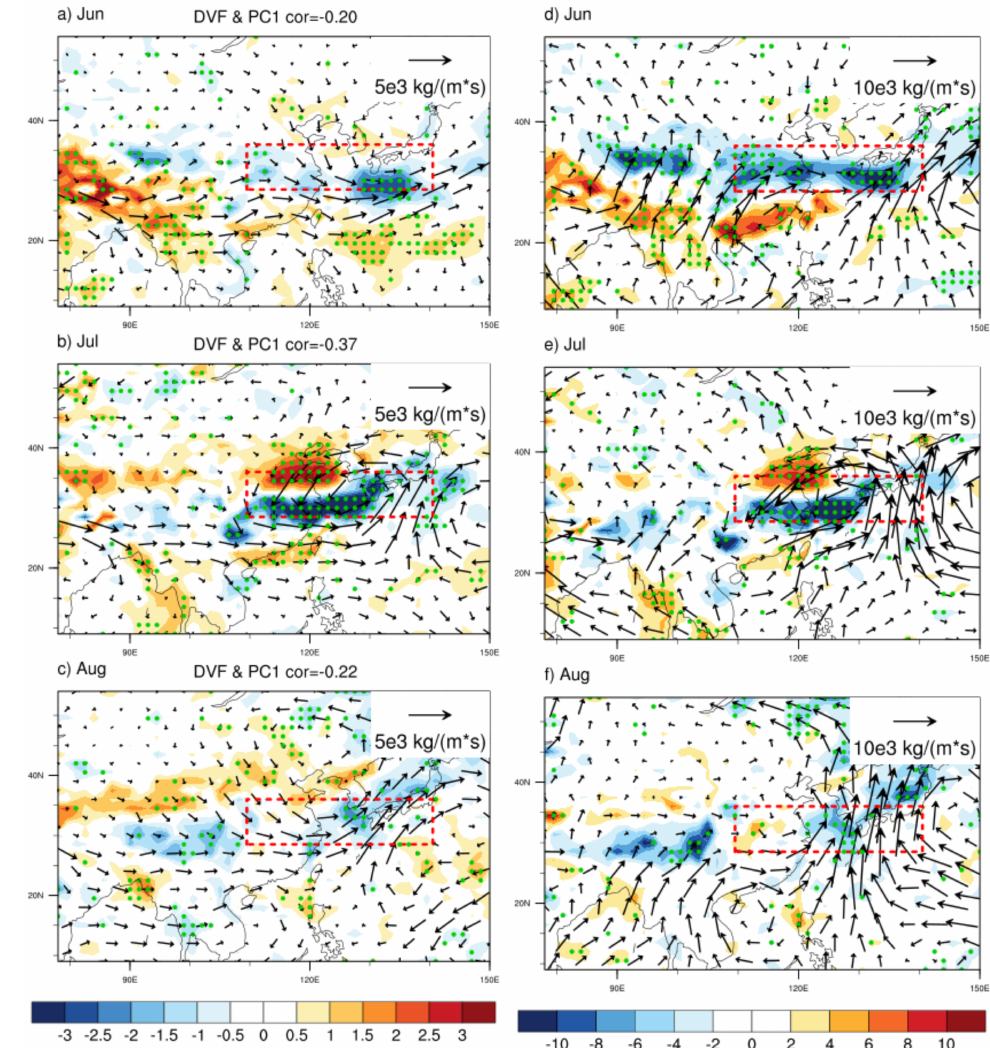
Figure 7. Regression maps ( a – c ) of divergence of vapor flux (DVF, shading) and vapor flux (vectors) integral from 900 hPa to 300 hPa onto PC1. The difference maps ( d – f ) of same elements between the five most positive years and the five most negative years in PC1. Stippled areas indicate DVF anomalies and differences that exceed the 90% confidence levels. Units: 10 × 10 − 5 kg/(m 2 ·